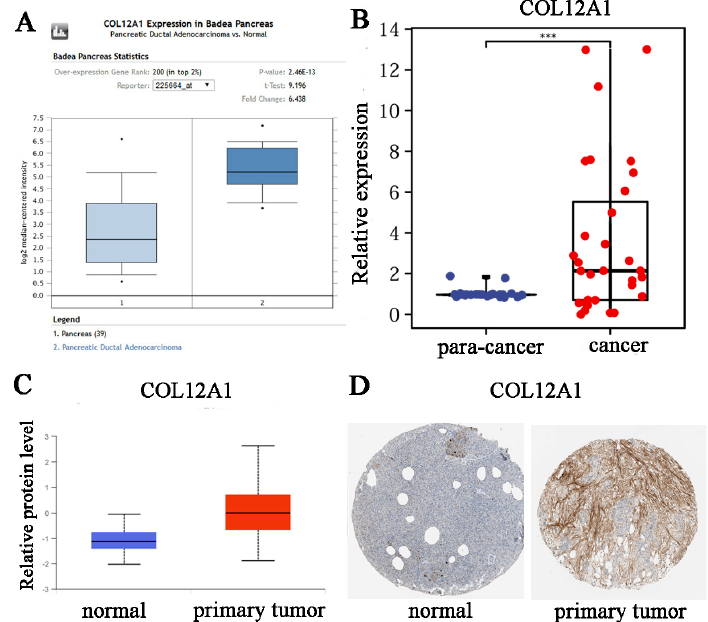
Figure 3. Verification that COL12A1 expression was much higher in tumor tissues than in para- cancer tissues. ( A ) Oncomine was performed to validate the expression of COL12A1 in pancreatic cancer samples compared with normal samples. ( B ) COL12A1 expression levels in 31 pairs of fresh pancreatic cancer tissues and their para-cancer tissues. (COL12A1/GAPDH). ( C ) Verified COL12A1 expression was much higher in tumor tissues than in normal tissues in the CPTAC datasets.